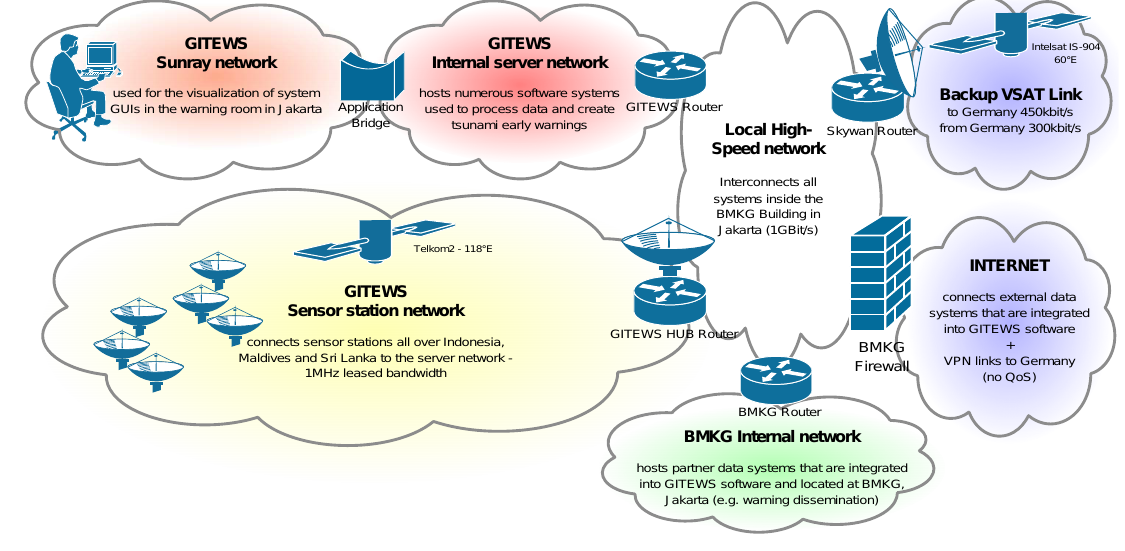
Fig. 18. Components and interconnections used in the warning